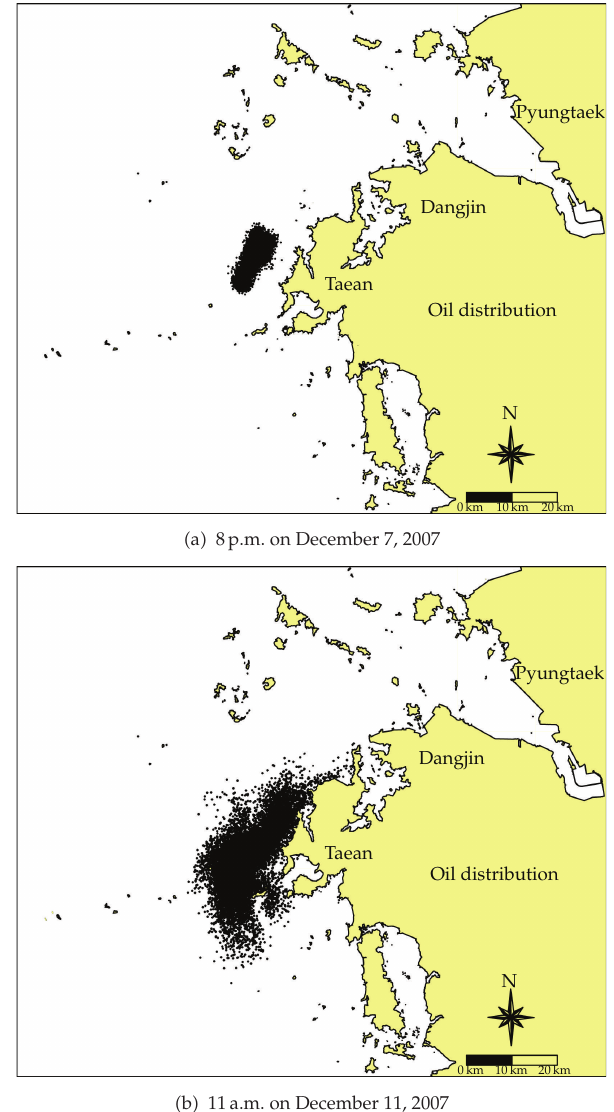
Figure 9: Computed di ff usion distribution of the Hebei Spirit oil